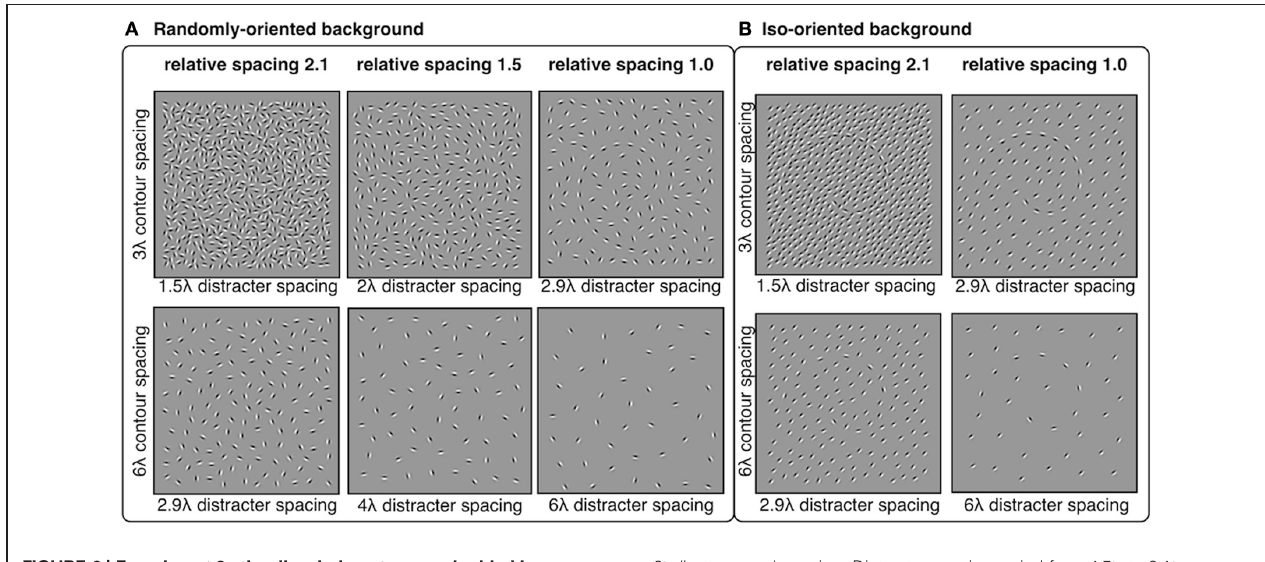
6 λ (bottom row) spacing. Distracter spacing varied from 1.5 λ to 6.1 λ , resulting in contour-distracter relative spacing ranging from 1.0 to 2.1. Three levels of relative spacing—1, 1.5, and 2.1—are shown here.